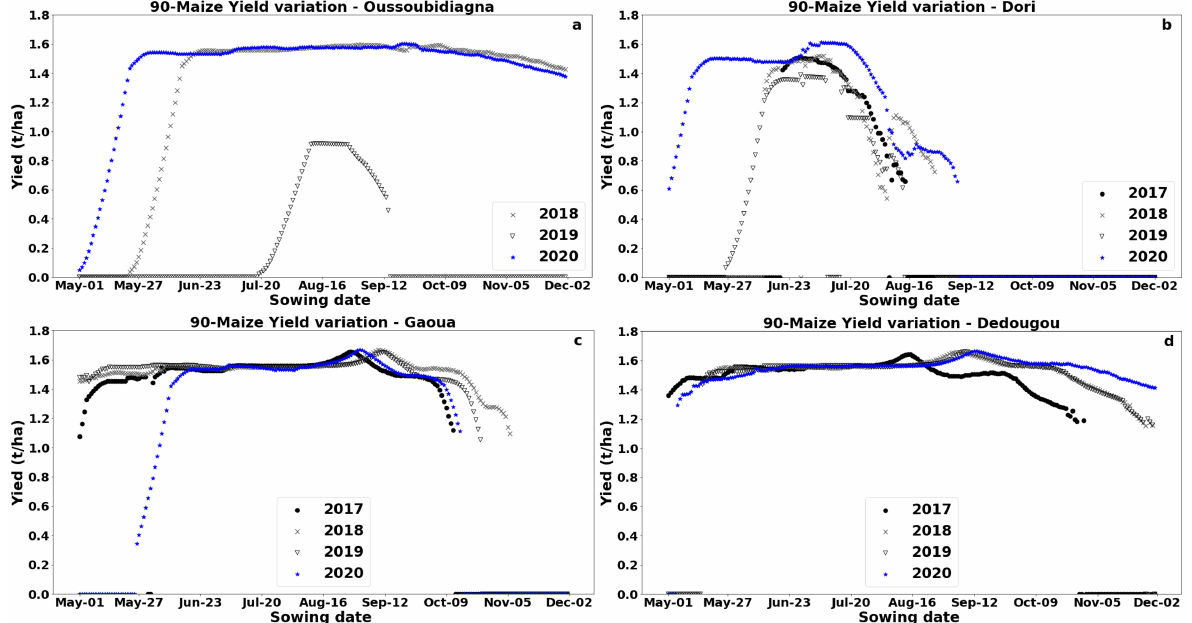
Figure 5. Variation in yield response for 90-day maize for each date of the sowing window from 1st May to 31st November at four selected locations: ( a ) Oussoubidiagna, ( b ) Dori, ( c ) Gaoua, and ( d )